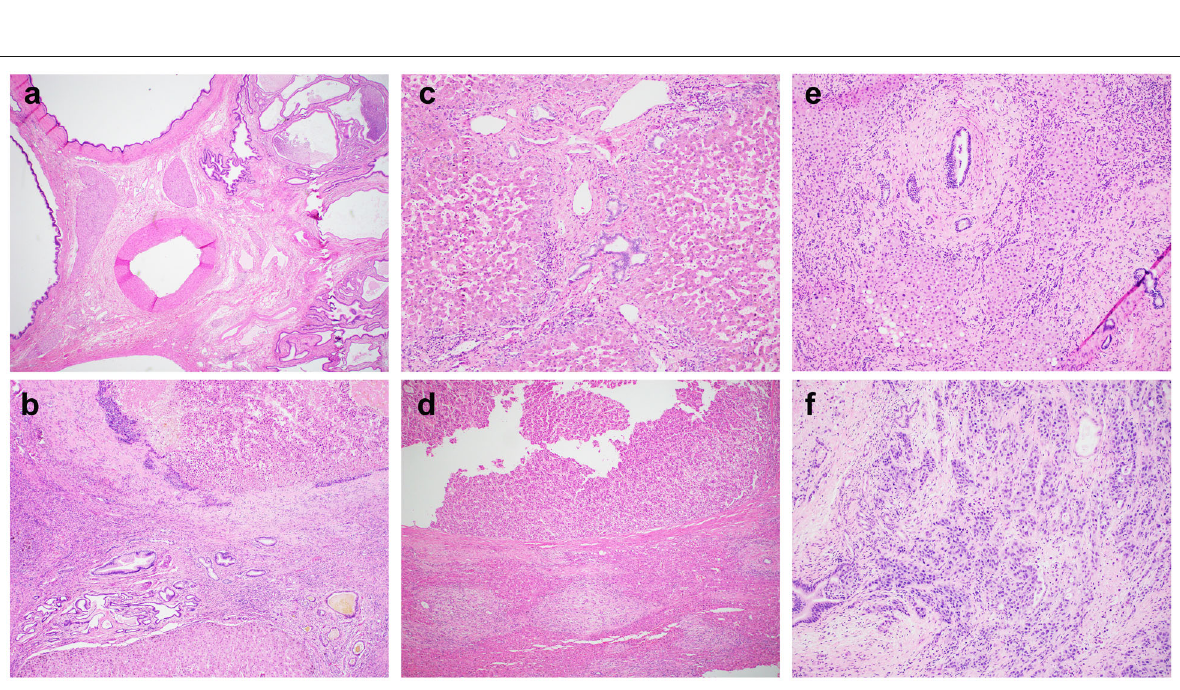
Fig. 4 Carcinomas associated with congenital hepatic fibrosis. Case 11 ( a-b ) showing numerous cystically dilated bile ducts in hilar area ( a ) and hepatocellular carcinoma ( b , upper half) with adjacent portal tracts ( b , lower half). Case 12 ( c-d ) showing background congenital hepatic fibrosis ( c ) and hepatocellular carcinoma ( d . upper half) with adjacent portal tracts ( d , lower half). Case 13 ( e-f ) showing background congenital hepatic fibrosis ( e ) and incidental findings of cholangiocarcinoma ( f ) involving a benign dilated duct. Magnification: a : 20X; b, c, e , f : 100X; d :